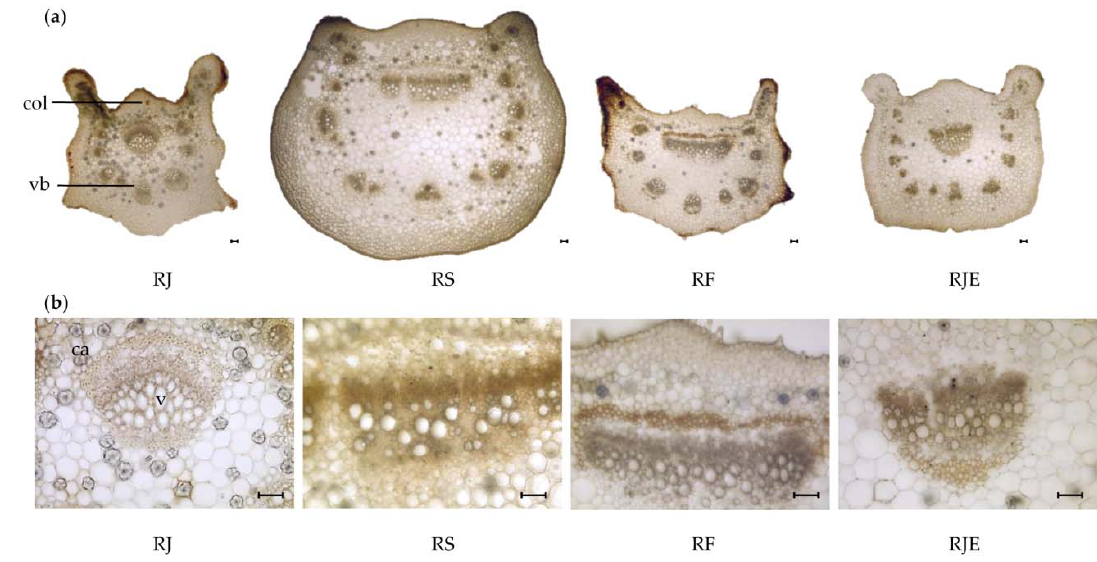
Figure 3. Photomicroscopic data of the petiole from four Reynoutria plants: ( a ) transverse section of the petiole; ( b ) transverse section of a vascular bundle located at the center of the petiole. The black bars mean 100 μ m. ca : druse; col : collenchyma cell; vb : vascular bundle; v : vessel. Table 3. Anatomical characteristics of the petiole from four Reynoutria plants.